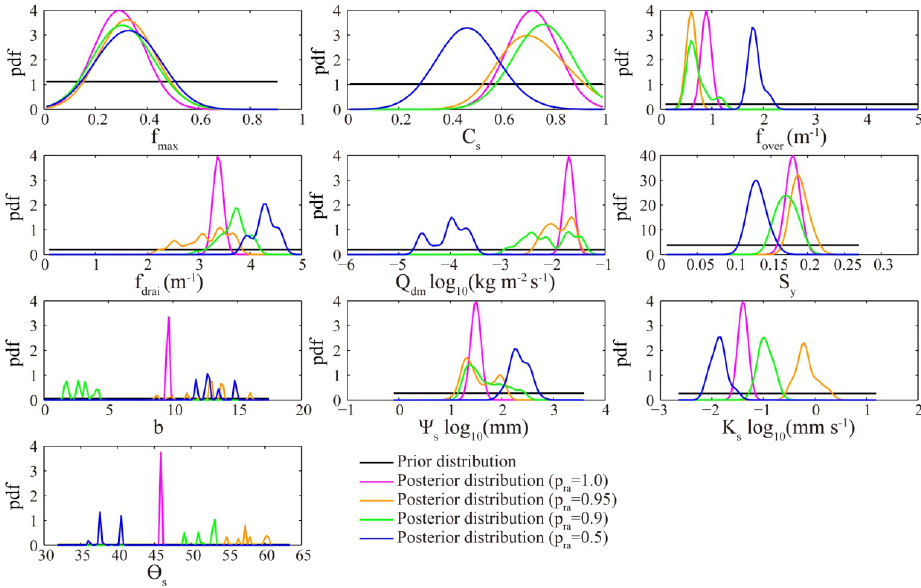
Figure 7. Posterior distribution of the parameters with four reference acceptance probabilities using monthly runoff data at the MOPEX basin.